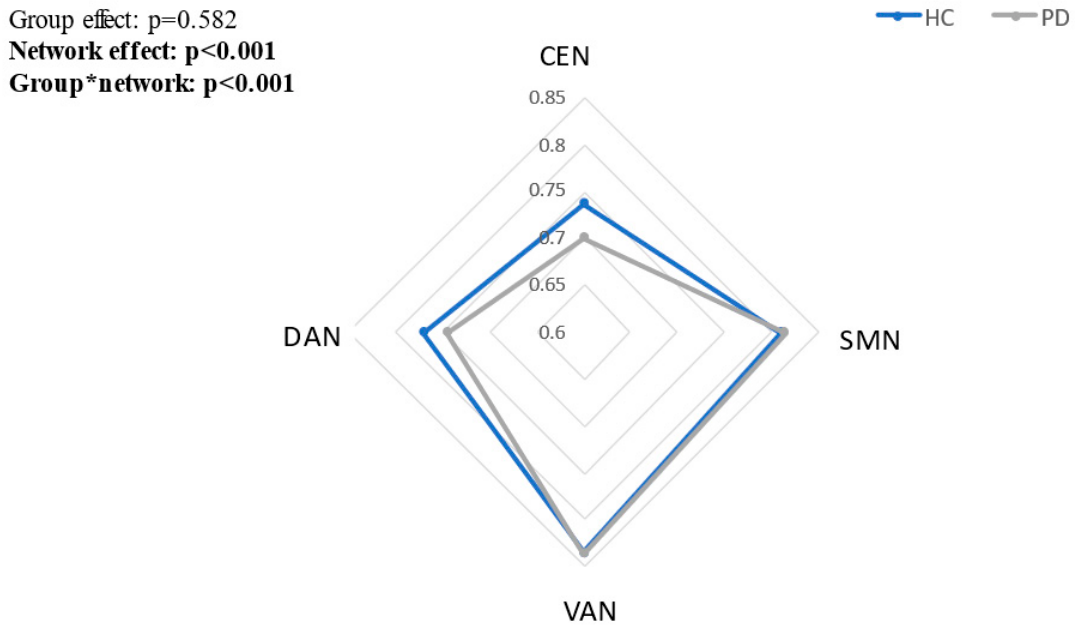
Figure 2. The percent number of significant tPDCs within each network in patients with PD and healthy older adults.